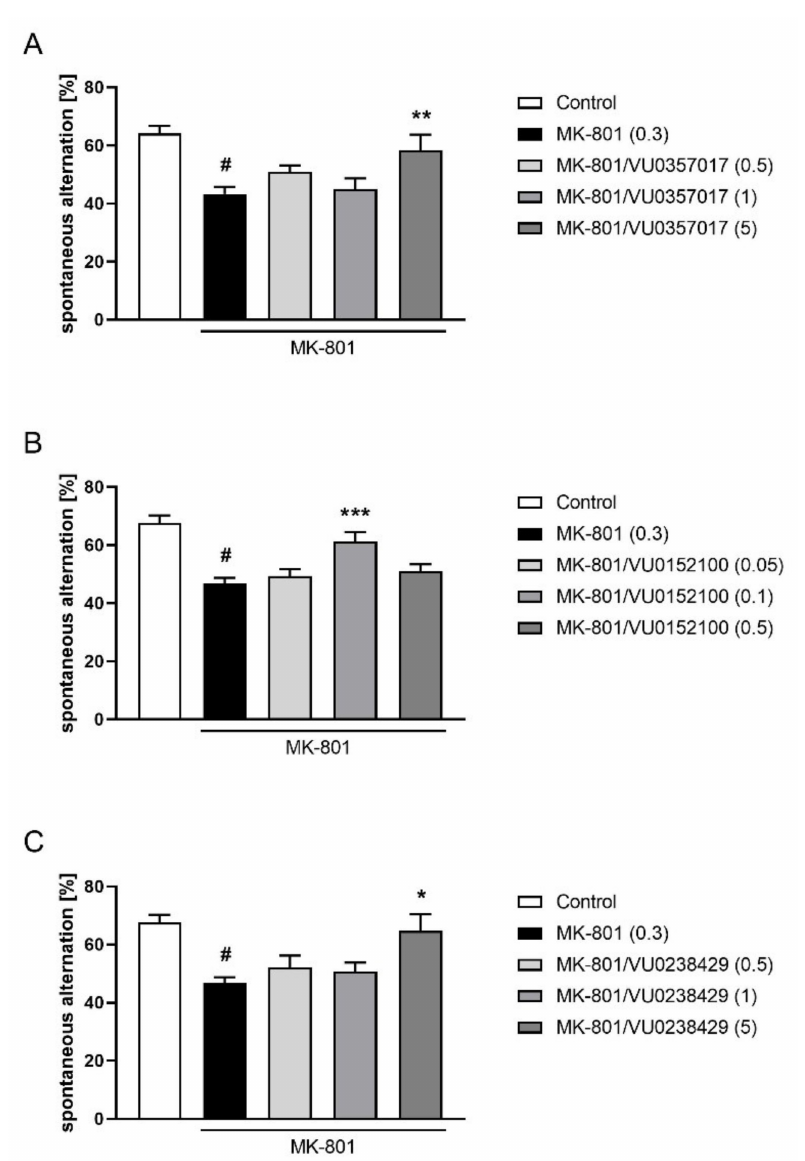
Figure 10. Activity of VU0357017 ( A ), VU0152100 ( B ), and VU0238429 ( C ) in the Y-maze test after seven days of administration. The data are presented as means ± SEM. Doses of the compounds are indicated in parentheses. # p < 0.001 compared to control animals and * p < 0.05, ** p < 0.01, *** p < 0.001 compared to MK-801-treated